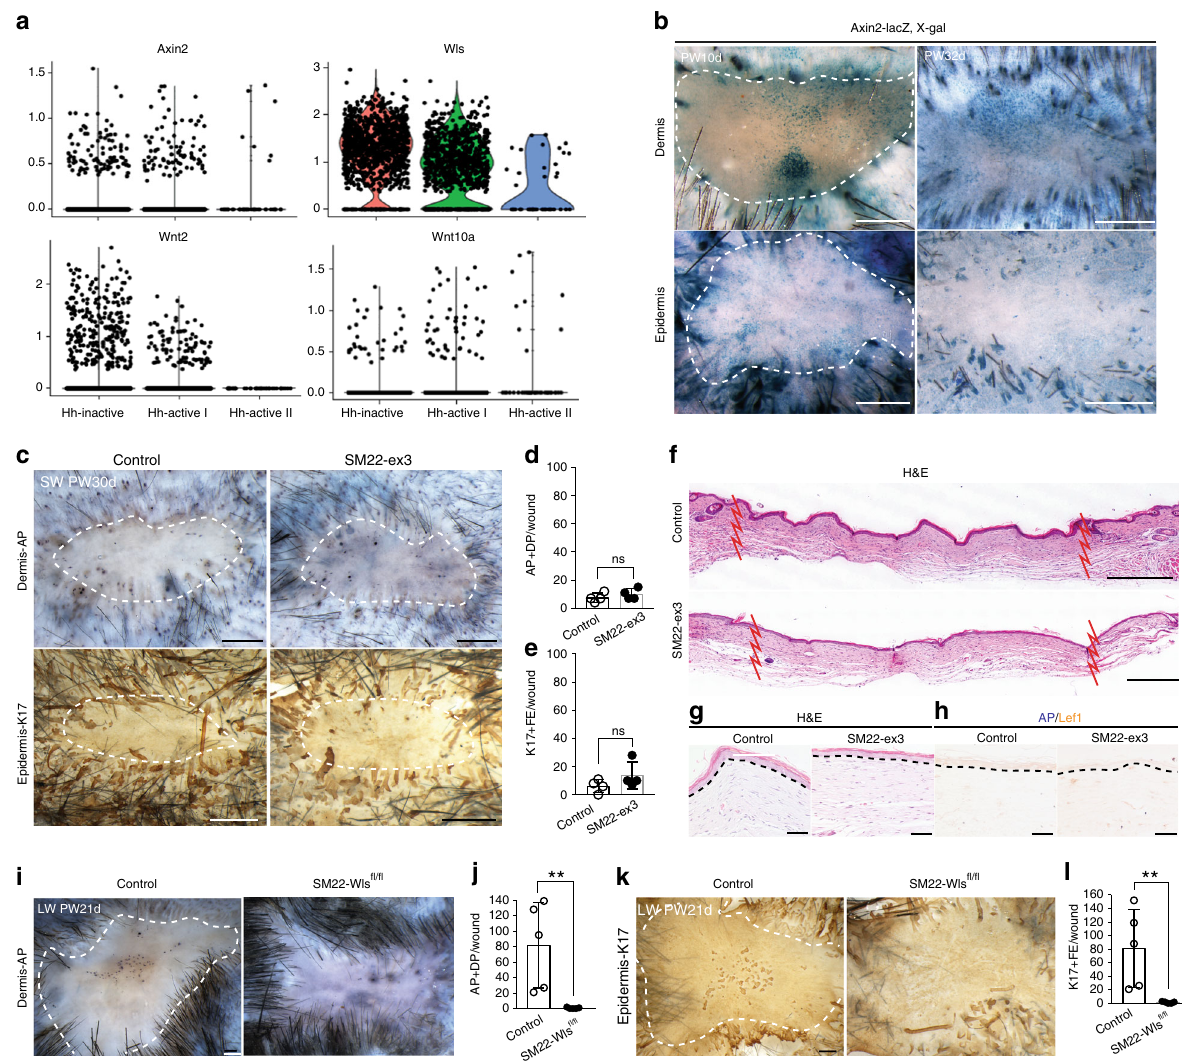
Fig. 5 Dermal Wnt activation alone is not suf fi cient for HFN. a Violin plots of Wnt pathway-related genes in SM22 + myo fi broblasts. b X-gal staining in epidermis and dermis of SW of Axin2-LacZ mice at PW10d and PW32d. c – h SM22-rtTA; tetO-Cre; β -catenin fl (ex3)/ + ( SM22-ex3) and littermate controls were subjected to SW and treated with doxycycline from PW1d until tissue harvest at PW30d ( n = 3 – 4 W (3 – 4 M) per condition). Whole-mount HFN assay ( c ) and quanti fi cations ( d , e ). H&E ( f , g ) and AP/Lef1 staining ( h ) show lack of hair germ (HG) formation by β -catenin activation in dermis. i – l SM22- rtTA; tetO-Cre; Wls fl / fl ( SM22-Wls fl / fl ) and littermate controls were subjected to LW and treated with doxycycline from PW3d until tissue harvest at PW21d ( n = 4 – 5 W (4 – 5 M) per condition). Whole-mount HFN assay ( i , k ) and quanti fi cations ( j , l ). n : number of wounds (W) or mice (M), Dashed white circle and zigzag line: wound boundary, Dashed line: epidermis – dermis border, SW small wound, LW large wound, AP alkaline phosphatase, PW post- wound, Scale bars represent 500 µ m ( b , c , i , k ), 100 µ m ( f ), 50 µ m ( g , h